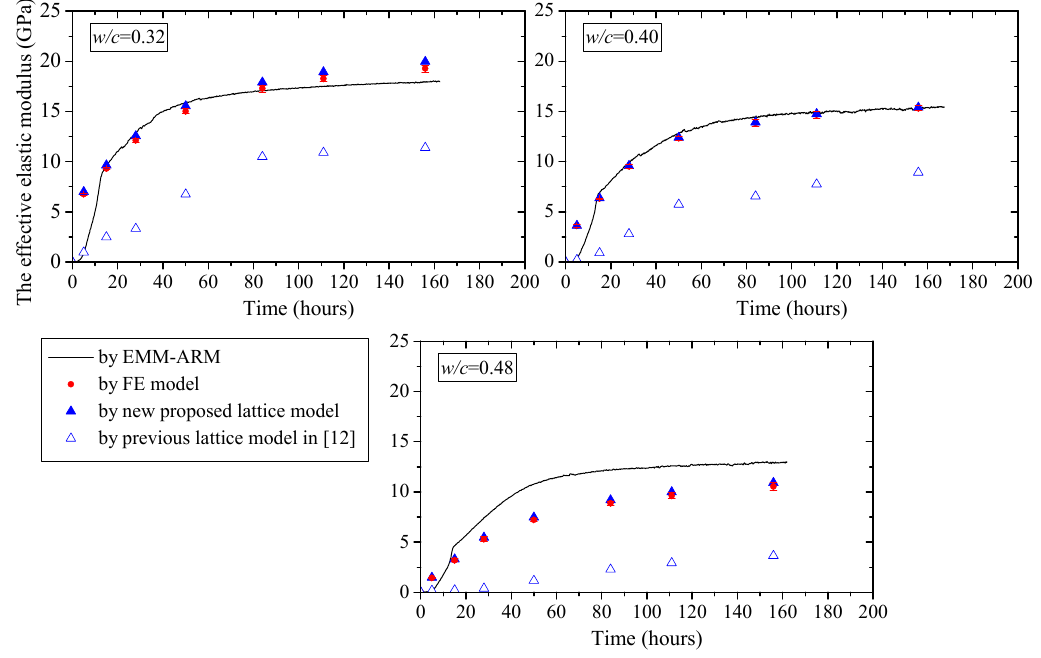
Figure 13. Young’s modulus of the cement paste: experimental vs. numerical results.